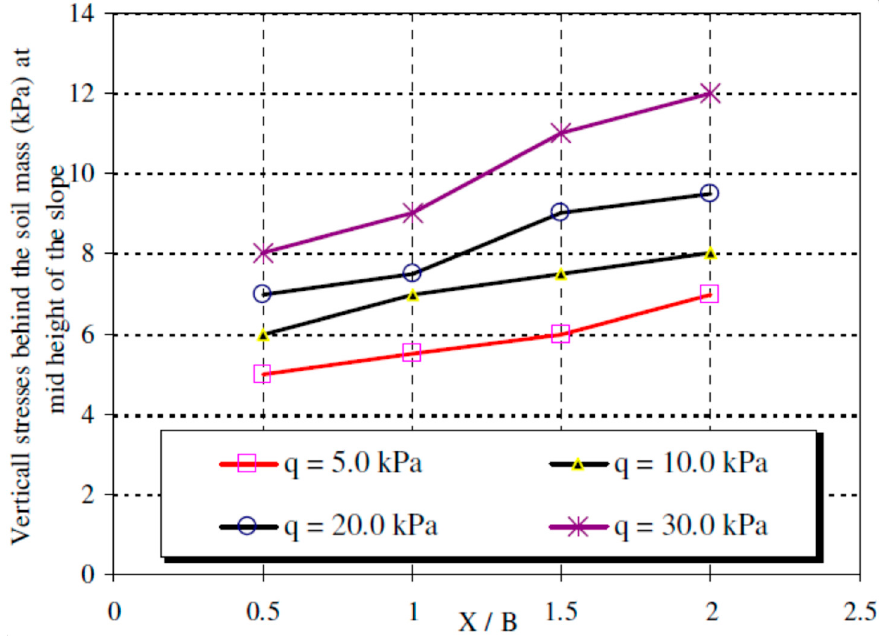
Figure 32. Influence of footing position on vertical stresses behind the nailed soil mass at mid-height of